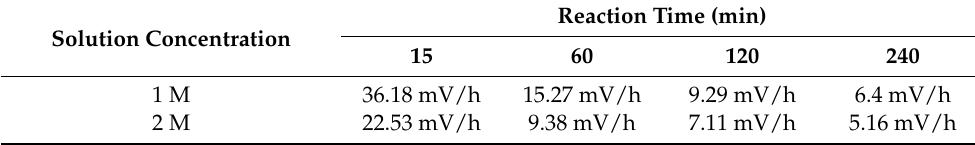
Table 1. Drift of the electrodes treated using different fabrication parameters.